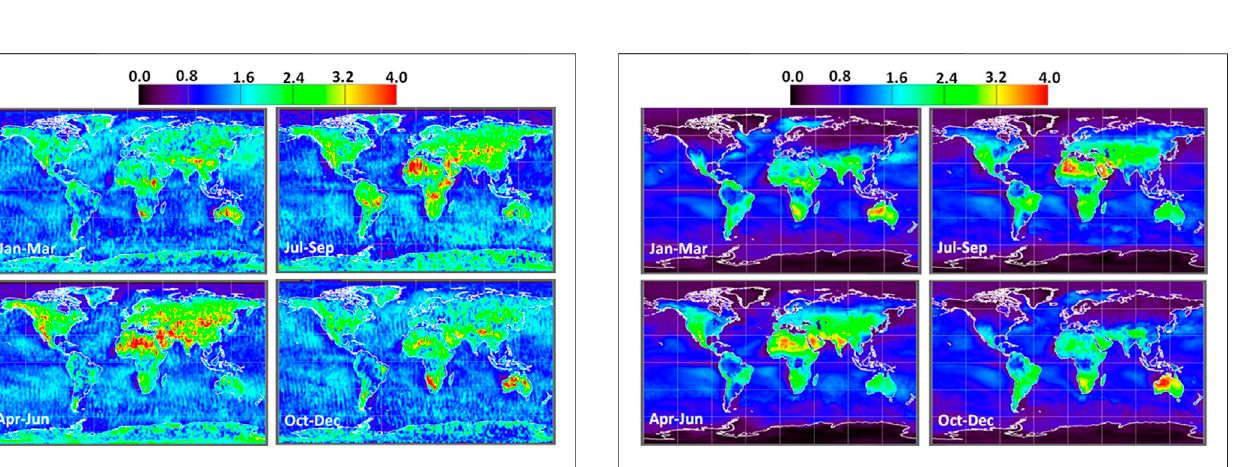
Frontiers in Remote Sensing |